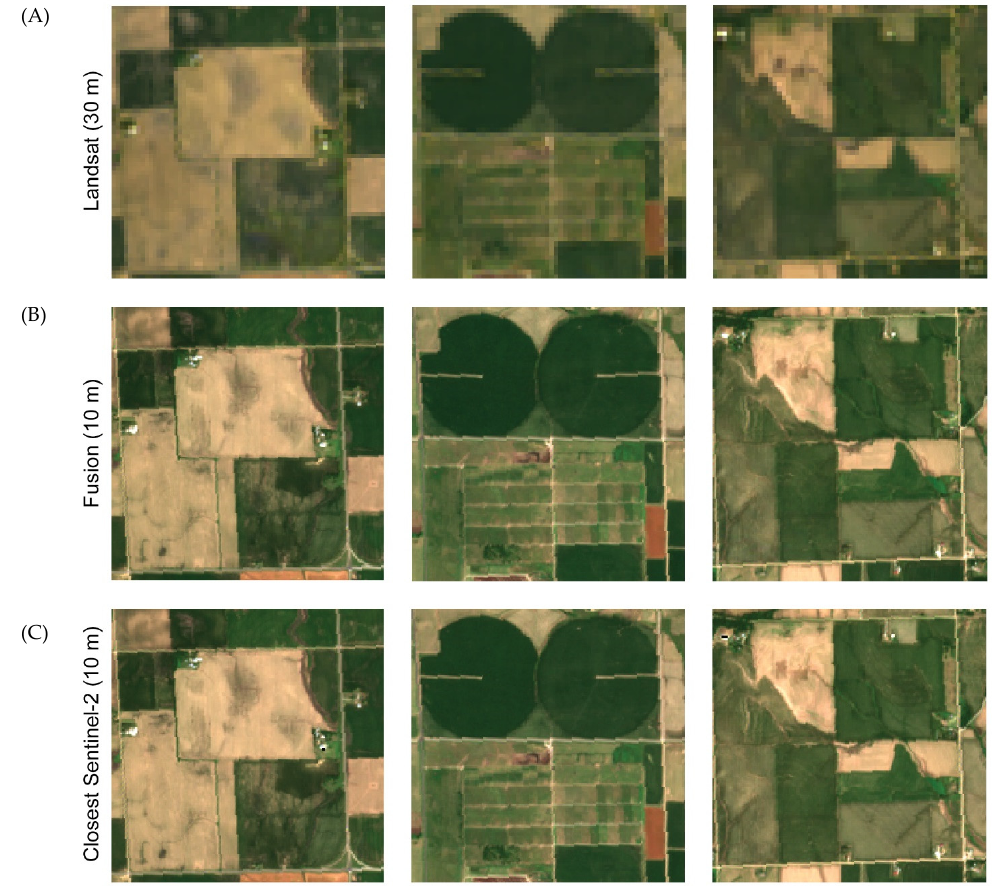
Figure 5. Comparison of the spatial texture details of the Landsat product (30-m resolution) and STAIR 2.0 fusion product (10-m resolution). The Landsat images ( A ) were acquired on 30 June 2017, while no Sentinel-2 image (10-m resolution) was available on that day. STAIR 2.0 was applied to generate 10 m-resolution images for this date ( B ). Sentinel-2 images ( C ) from the closet date (29 June 2017) are shown for reference. All images are visualized in RGB composition.